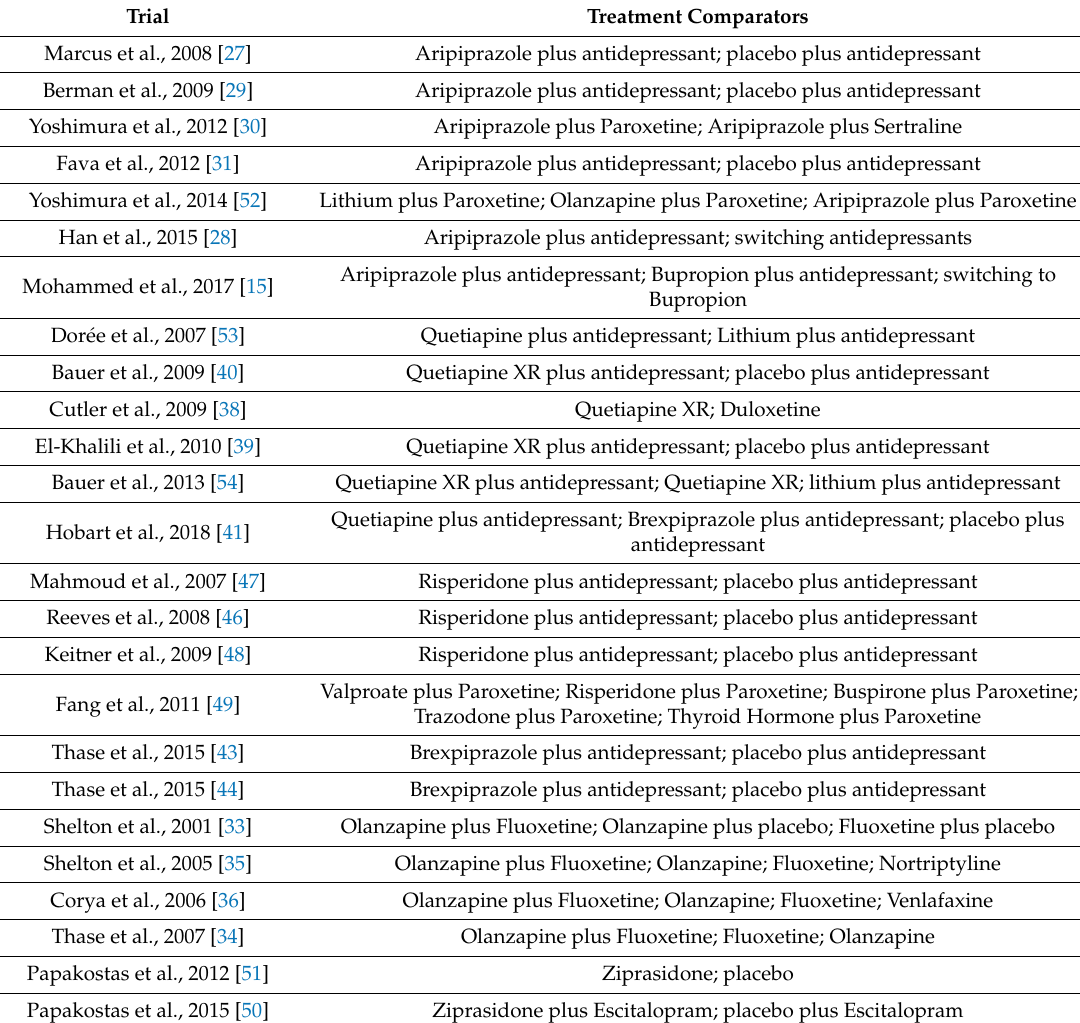
Table 4. List of Included Second Generation Antipsychotic